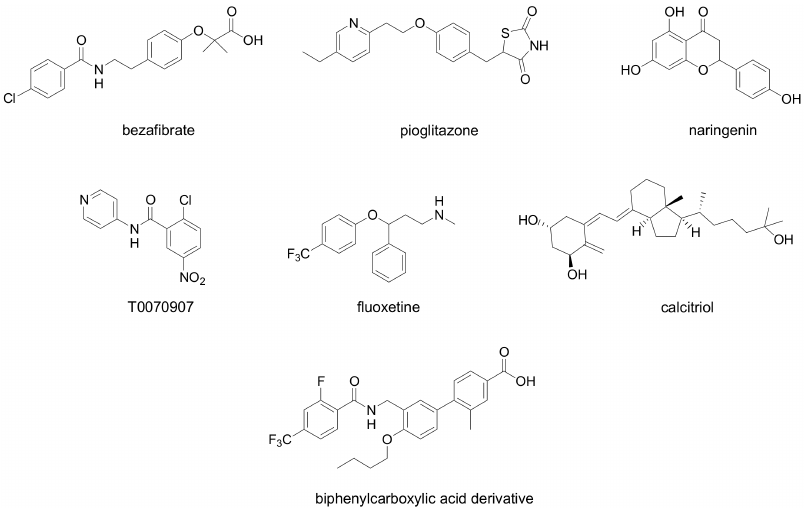
Figure 4. Chemical structures of natural and synthetic PPAR ligands displaying in vivo or in vitro efficacy in HCV infection